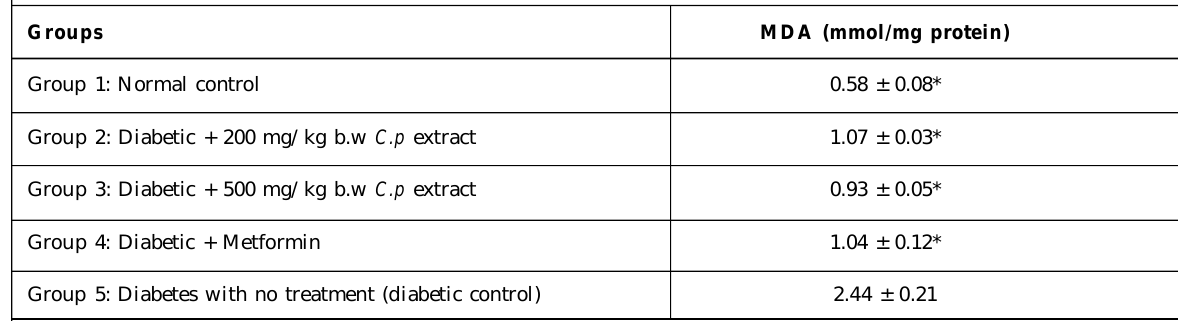
Table 4: The Mean ± SEM of the MDA level of the Normal control, those treated with C.p extract, metformin and diabetic control (untreated) of the Wistar rats after 21 days Groups